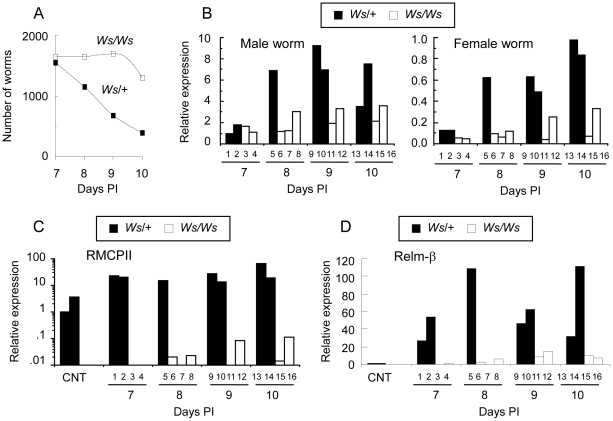
Hsp gene expression in adult worms in mast cell-deficient rats.
A. Mean worm burdens in the small intestine of mast cell-deficient Ws/Ws and the control Ws/+ rats after infection with 2,000 infective-L3 larvae. B. Nb-Hsp12.6 gene expression levels in male and female worms recovered from Ws/Ws and Ws/+ rats. Individual data are shown with rat ID numbers (1–16) beneath the columns. The expression level in the male worms from rat No. 1 is shown as 1.0. C. Gene expression levels of RMCP II in the intestinal mucosa of Ws/Ws and Ws/+ rats. The expression level in one of the uninfected Ws/+ rats (CNT) is shown as 1.0. D. Gene expression levels of Relm-β in the intestinal mucosa of Ws/Ws and Ws/+ rats. The level in one of the uninfected Ws/+ rats (CNT) is shown as 1.0.